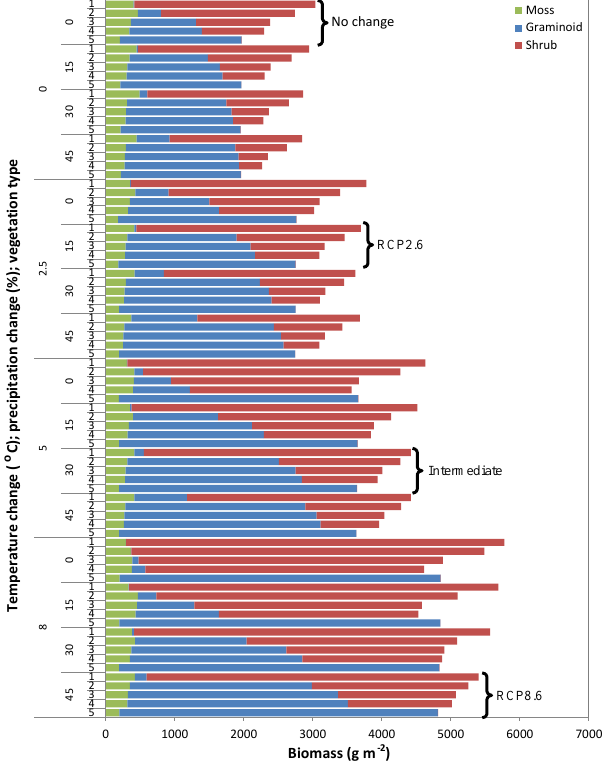
Figure 5. Simulated summer biomass of moss, graminoids and shrubs averaged over 2065–2074 for 16 climate scenario simula- tions in five vegetation types representing a gradient from relatively dry to wet conditions. Temperature and precipitation changes were based on 21st century RCP climate change scenarios. Biomass is total biomass (above and belowground).